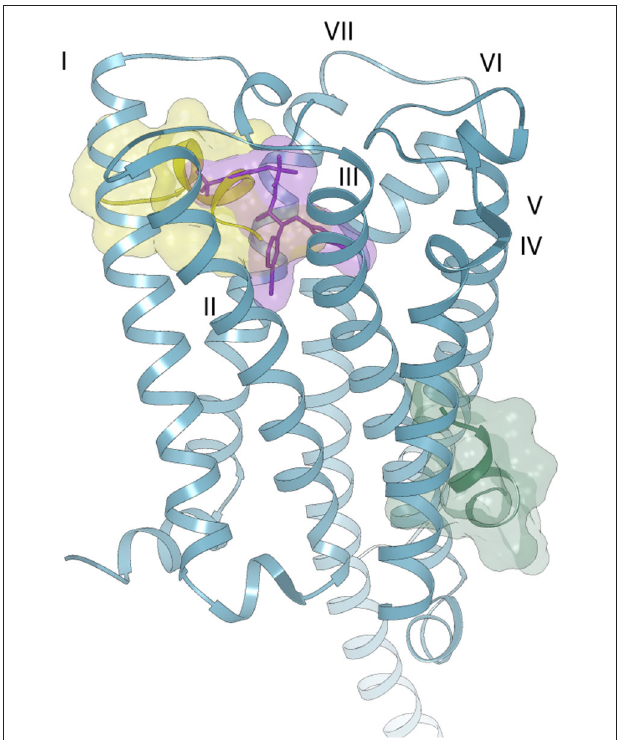
FIGURE 6 | Possible binding modes of Pepcan-12 (yellow and green surfaces) to the CB1 receptor (blue ribbon) (PDB code 5U09). The orthosteric binding site is highlighted by the presence of a taranabant molecule (purple stick and